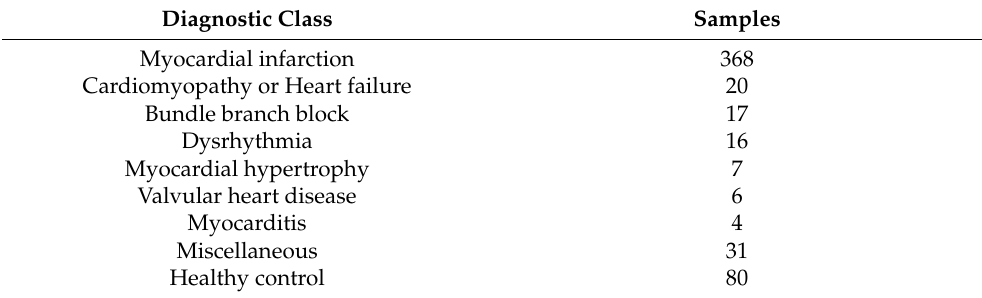
Table 1. Number of electrocardiograms samples by diagnostic class in Physionet.